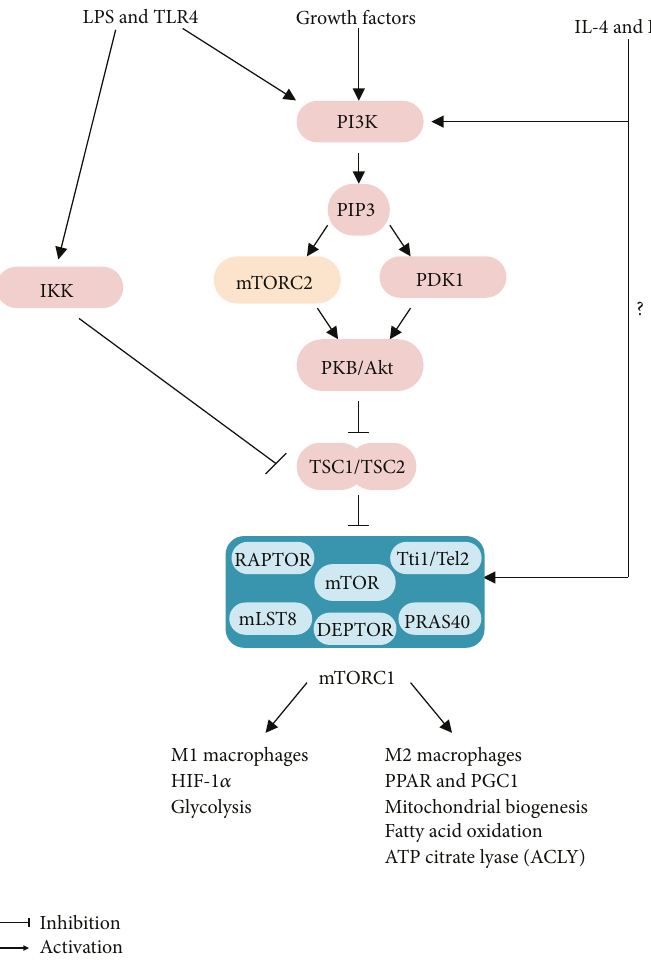
Figure 3: mTORC1 is activated in both M1 and M2 polarization and regulates important metabolic processes at both conditions. AA: amino acids; ACLY: ATP citrate lyase; HIF-1 α : hypoxic inducible factor 1 α ; IL-4: interleukin 4; IL-13: interleukin 13; PGC1 α : PPAR γ coactivator 1 α ; PPAR γ : peroxisome proliferator-activated receptor γ ; TLR4: toll like receptor